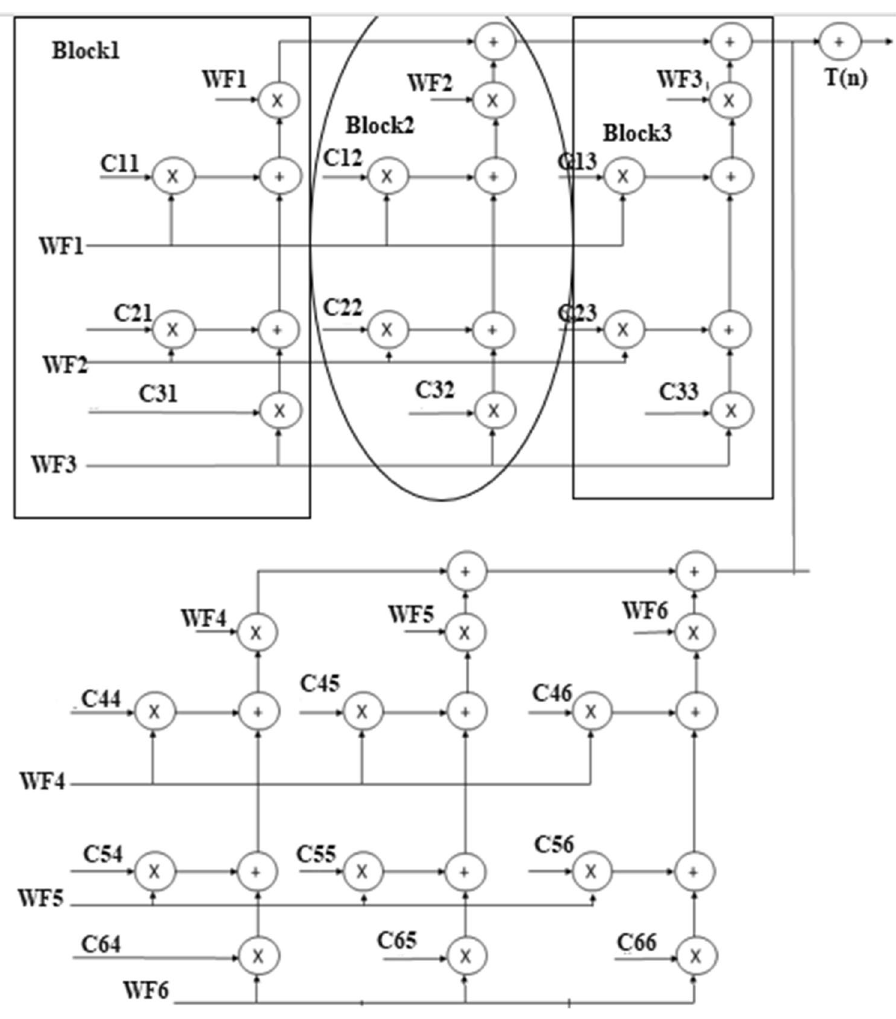
Figure 4. GLRT structure with blocks 4